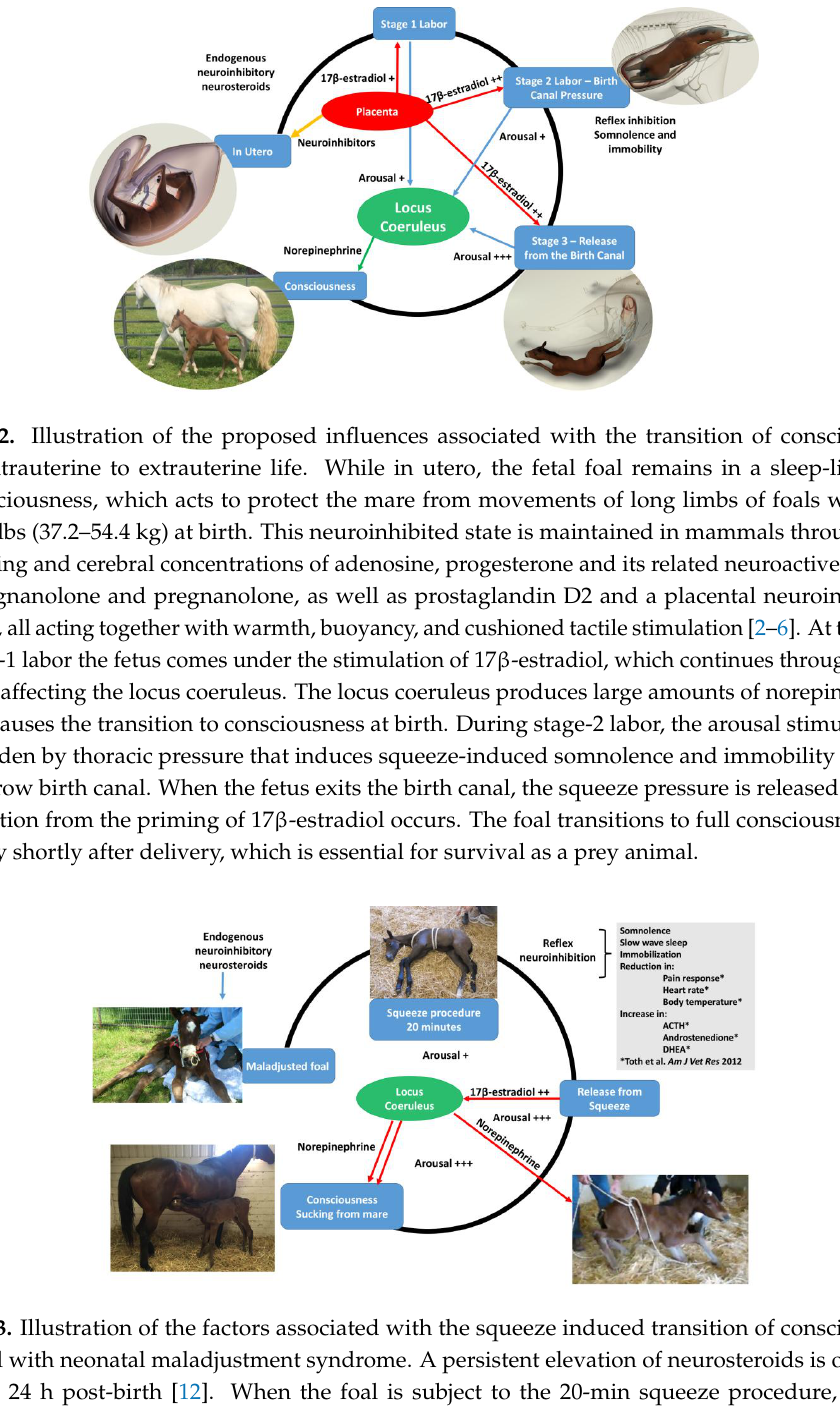
Figure 4. Illustration of the proposed influences associated with states of consciousness, physiological functions, and physical factors affecting the fetal foal in utero, stage 2 labor, and immediately post- birth. In utero, neuroinhibitory factors cause inhibition of movement and consciousness. At this stage, the fetus receives oxygen and nutrition from the placenta, and organs such as the gut and lungs are quiescent. During stage 2 labor, birth canal pressure produces immobility and further neuroinhibition associated with mild hypoxemia and hypercapnia. Immediately upon exiting the birth canal, thoracic squeeze pressure is reduced, releasing neuroinhibition. Physical factors such as skin sensation,